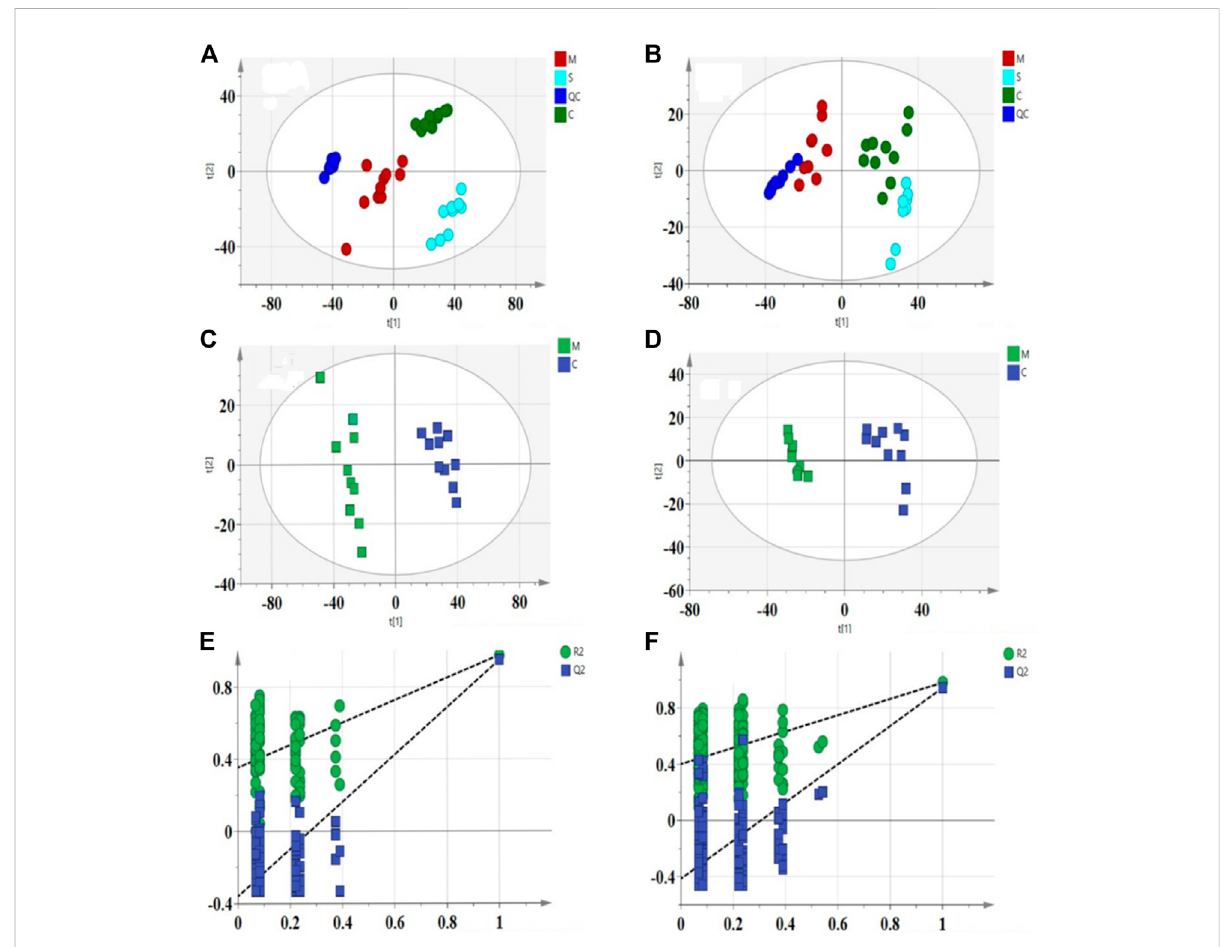
FIGURE 5 PCAscorescatterplotsforliversamplesfrom3groupsinthepositive (A) :R 2 X=0.872,Q 2 =0.785)andnegative (B) :R 2 X=0.745,Q 2 =0.661)ESI mode. OPLS-DA score scatter plots for C and M groups in the positive (C) : R 2 X = 0.626, R 2 Y = 0.998, Q 2 = 0.98) and negative (D) : R 2 X = 0.814, R 2 Y = 0.9958, Q 2 = 0.966) ESI mode. Permutation test of lipid species OPLS-DA model in positive mode (E) : R 2 = 0.354, Q 2 = − 0.359) and negative mode (F) : R 2 = 0.47, Q 2 = −